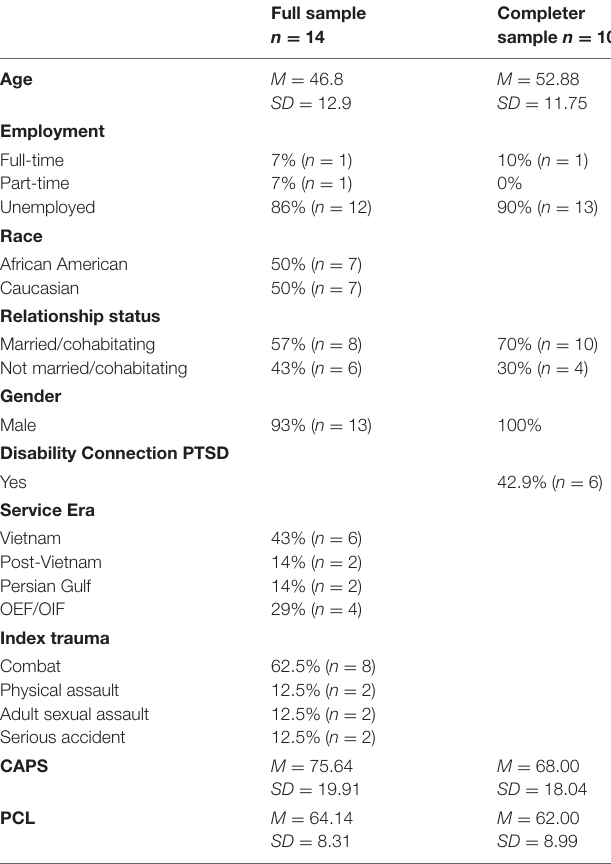
TABLE 1 | Demographics and baseline symptom